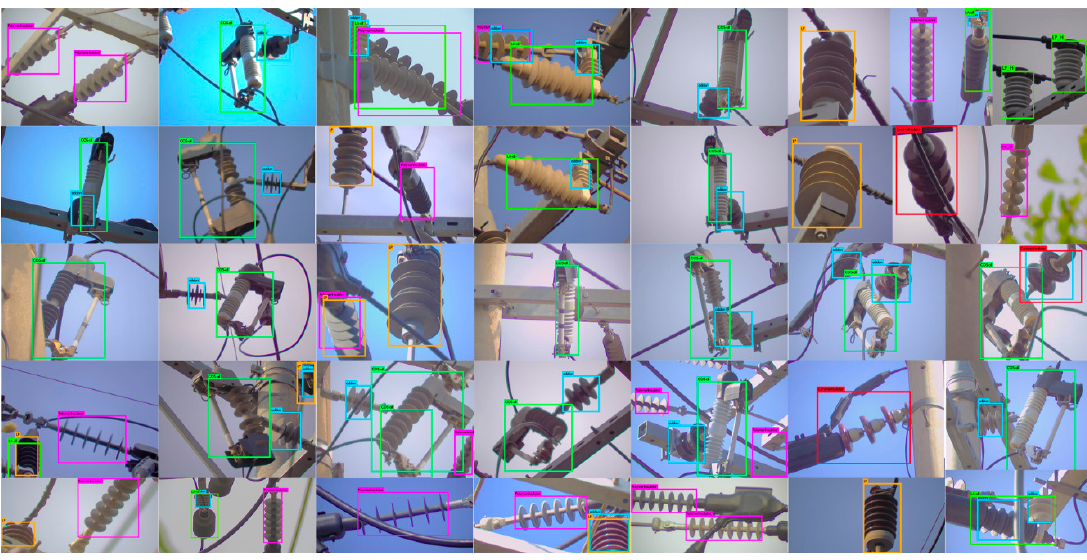
Figure 4. Different electrical equipment detection results by our CNN-based rotation invariant HR_1 detector. These detection results show that the used CNN-framework is very good at detecting different shapes in the cluttered environment under partial occlusion, and it is invariant against view-point, shape, size, color and lighting variations.